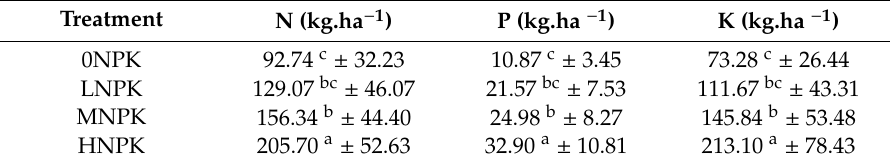
Table 6. Long-term mean removal of nutrients in harvested plant biomass.